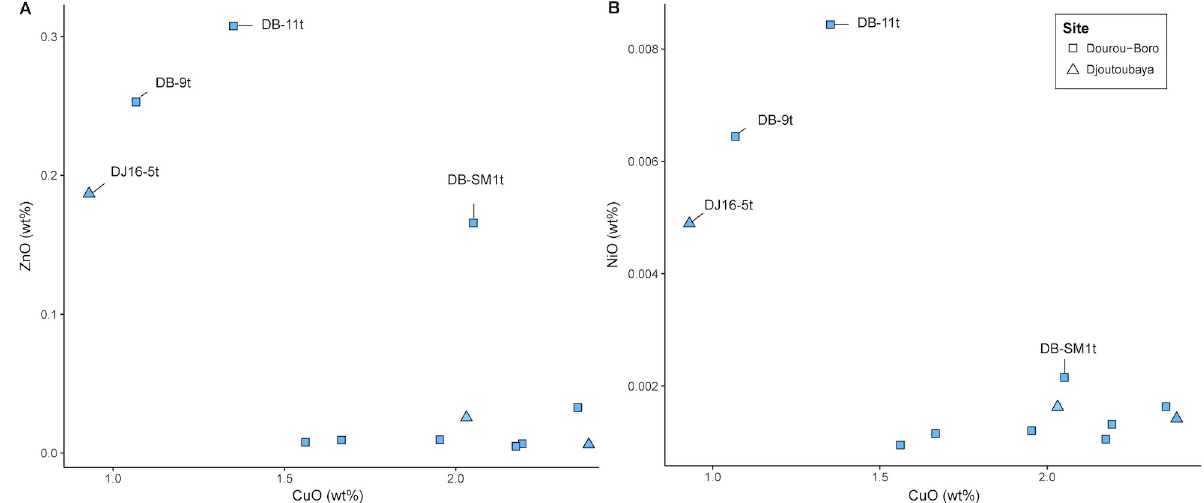
Fig 9. Different origins of the turquoise beads copper colorants. Zinc to copper (A) and nickel to copper (B) show that beads DB-9t, DB-11t, and DJ16-5t have been coloured with the same type of colouring agent, which is different from those used for the other turquoise